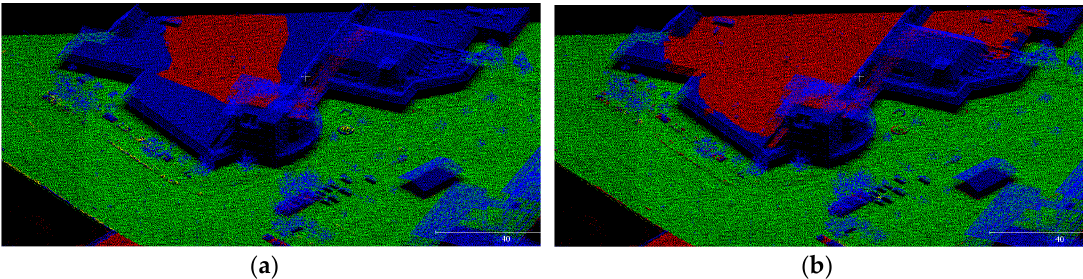
Figure 11. Error result on a very large building: ( a ) FCN; ( b ) LAStools. Red points are those incorrectly labeled as ground points.